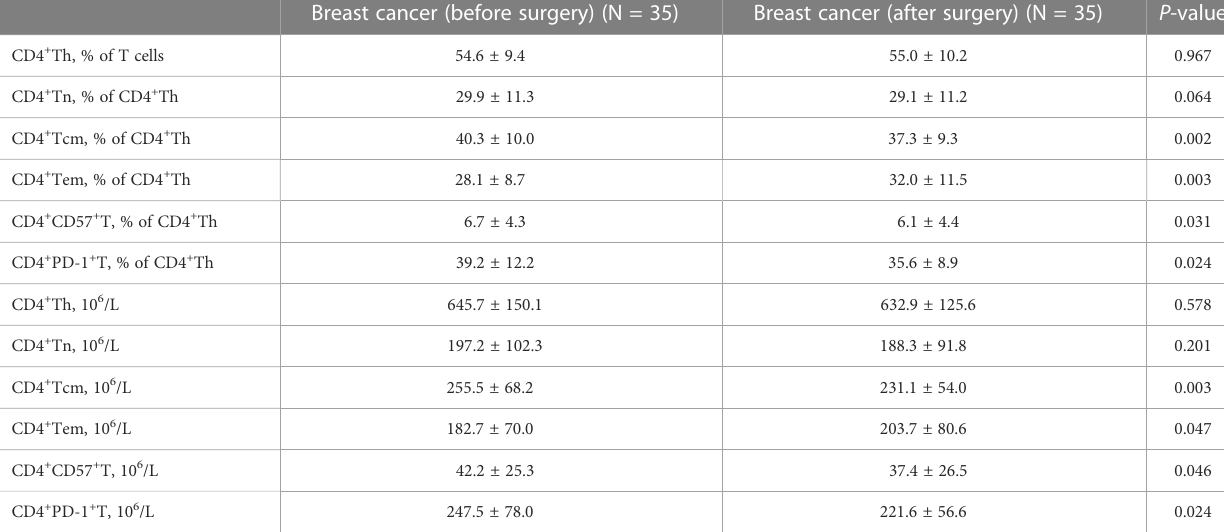
TABLE 3 Dynamic changes in CD4 + Th subsets in patients with breast cancer before and after surgery.